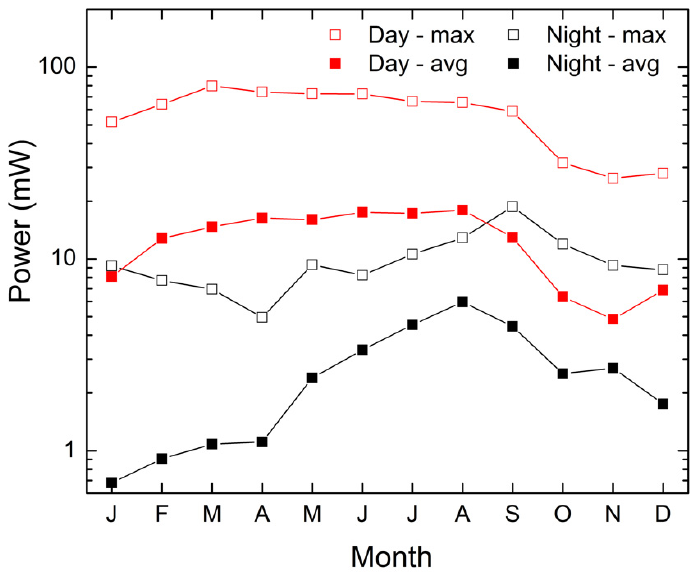
Figure 14. Monthly maximum and mean values of output power obtained during day and night periods. Data available in the Supplementary Materials.